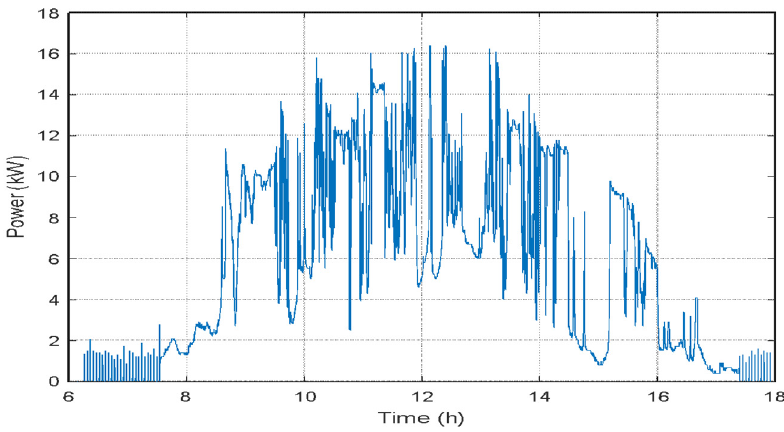
Figure 2. Typical behavior of power generation in the photovoltaic (PV) system under study (13 November 2018).